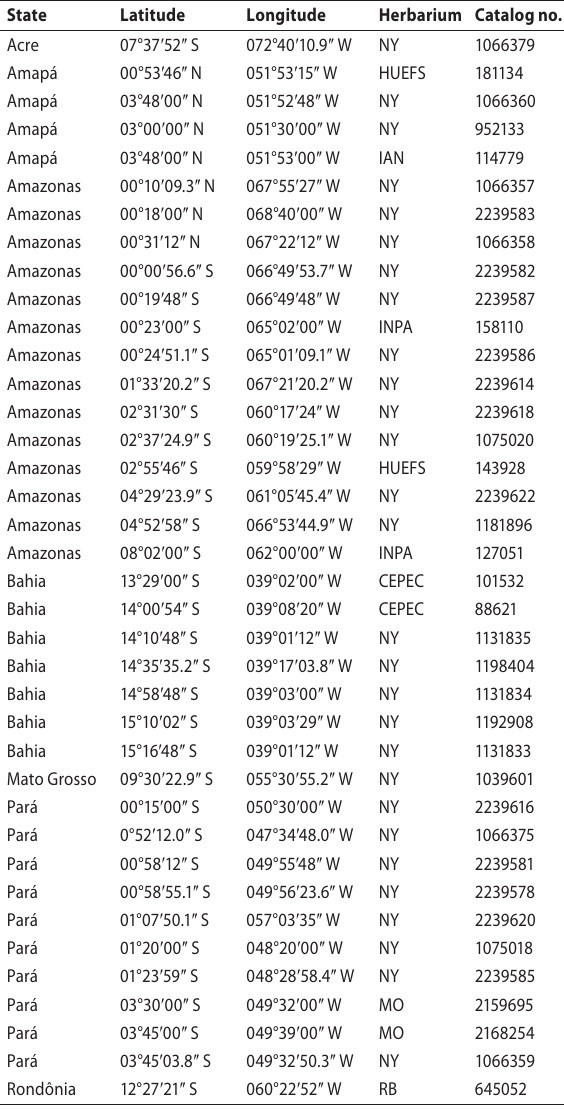
Table A1. Collection records of Rapatea paludosa in Brazil used for producing of the distributional map. Herbaria acronyms follow Thiers